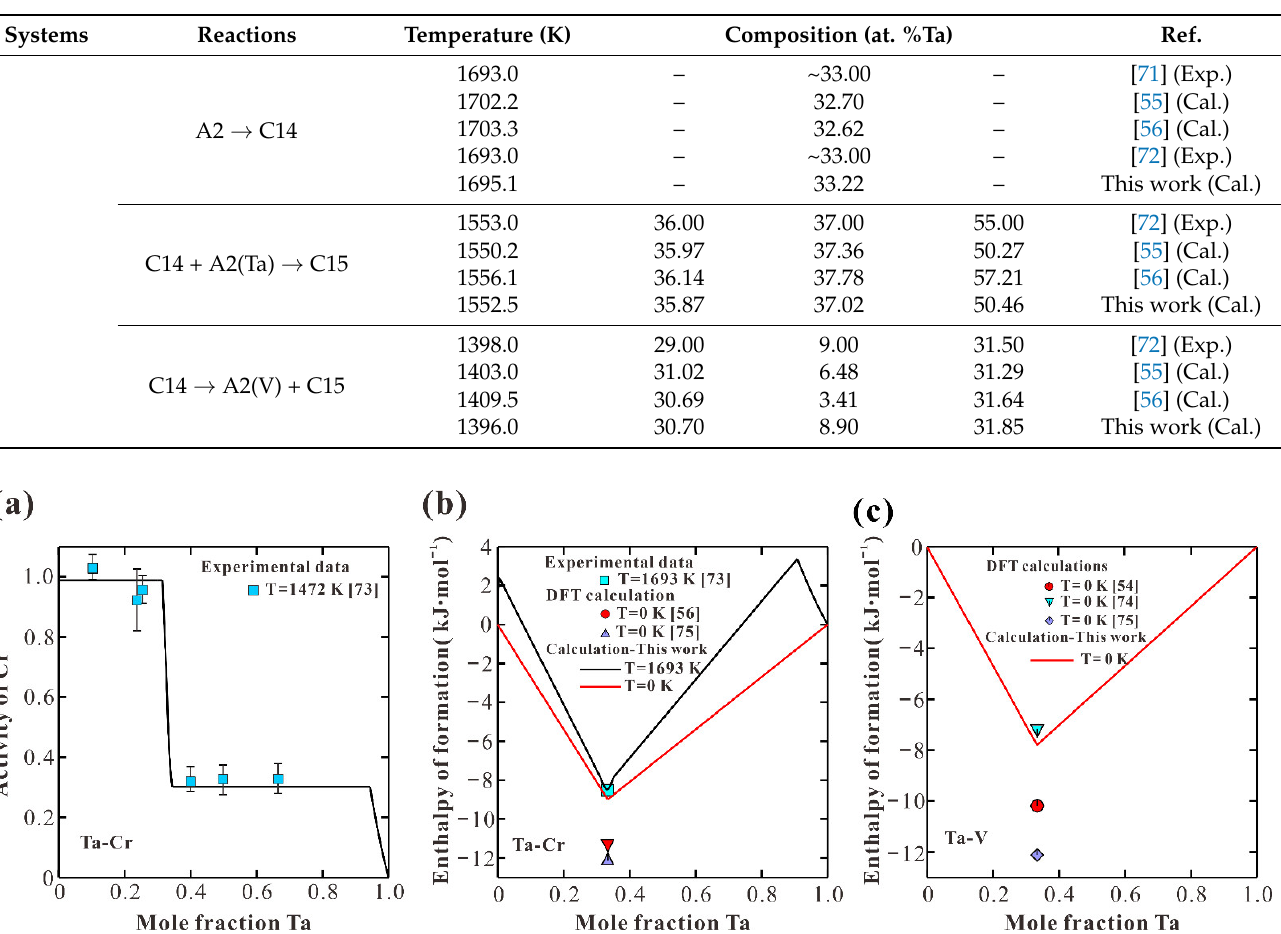
Figure 4. Calculated thermodynamic properties in Ta−Cr and Ta-V systems together with reported data [54,56,73–75]: ( a ) activity of Cr in Ta-Cr system at 1472 K; ( b ) enthalpy of formation in Ta-Cr system at 0 and 1693 K; ( c ) enthalpy of formation in Ta-V system at 0 K. Table 3. Calculated temperatures and compositions of invariant reactions in Ta-Cr and Ta-V binary systems in comparison with the measured ones [67–72] and previous calculated ones [53–56].